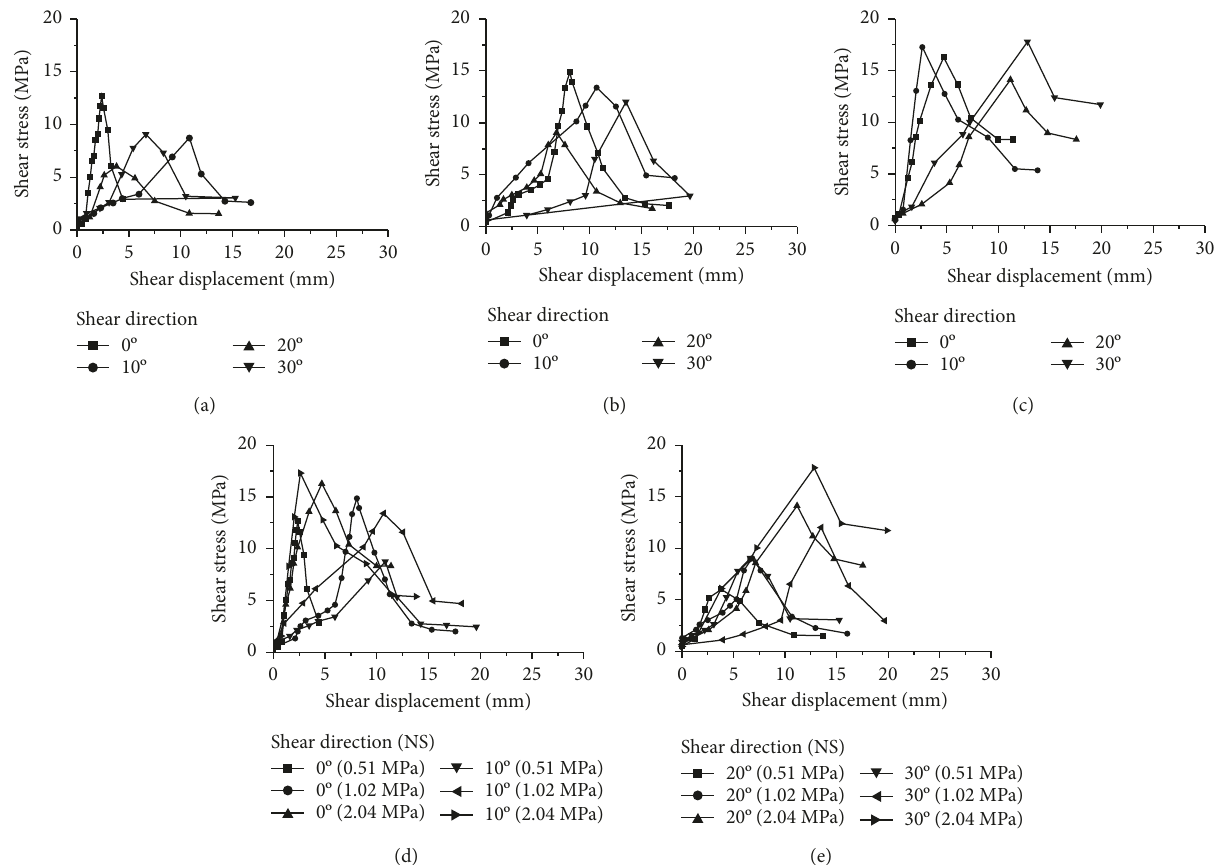
Figure 21: Shear strengths and displacements of the subsamples with natural rough rock joint surface model (A4). (a) NS (b) NS 1.02MPa; (c) NS (cid:31)